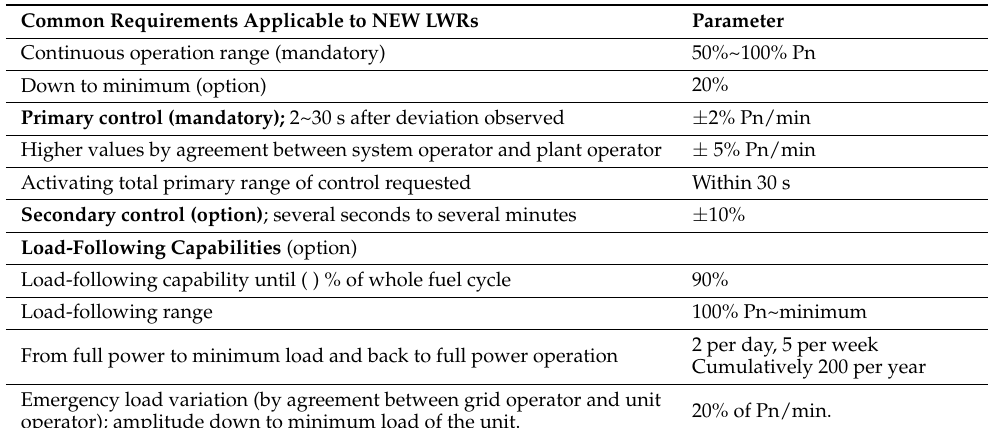
Table 4. Power Margins of European Light Water Reactor